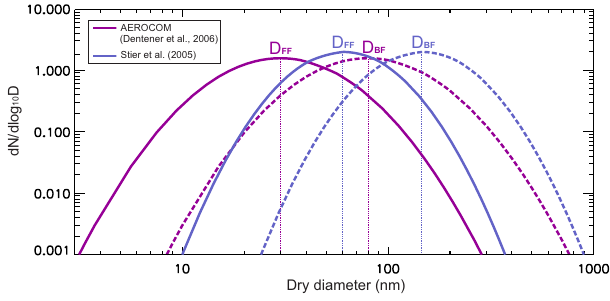
Fig. 2. Normalised log-normal size distributions used in GLOMAP to calculate carbonaceous particle number concentrations from fos- sil fuel (FF; solid line) and biofuel (BF; dashed line) emissions. Shown are two sets of log-normal size distribution parameters (number median diameter ( D ) and standard deviation) from AERO- COM (Dentener et al., 2006) and Stier et al. (2005) that are widely used in global aerosol